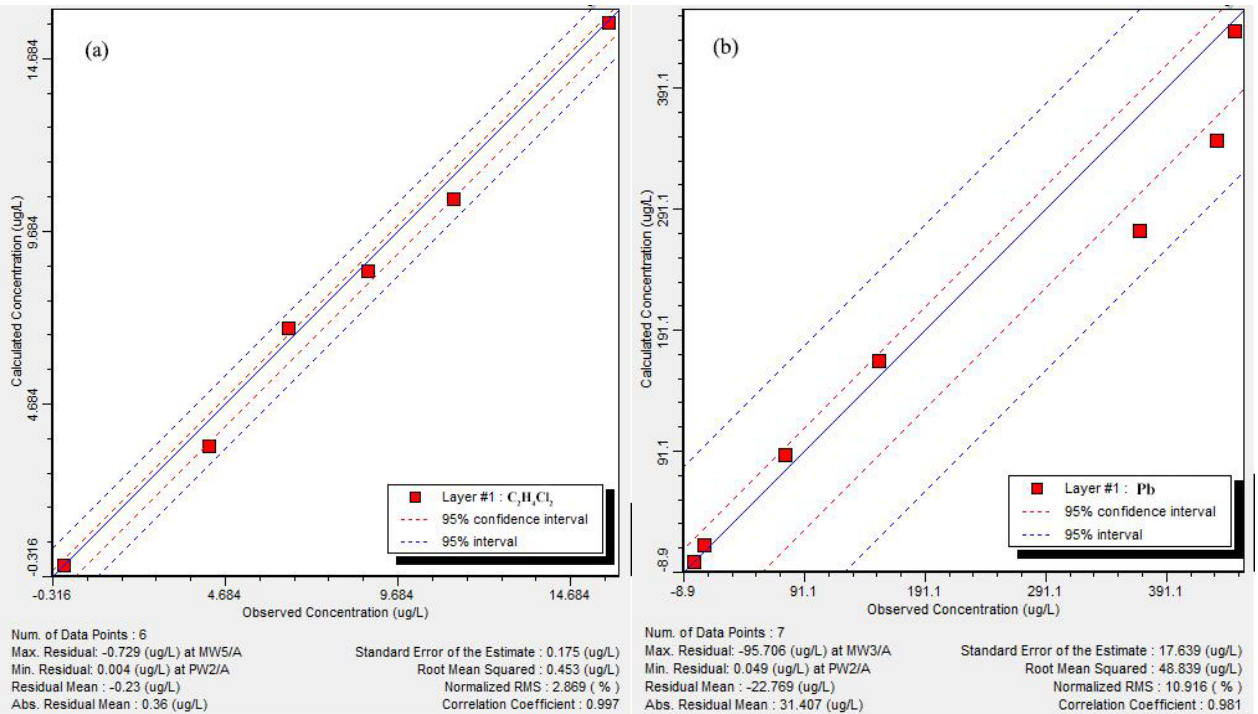
Figure 2. ( a ) Residual analysis of predicted and detected dichloroethane; ( b ) Residual analysis of predicted and detected Pb.